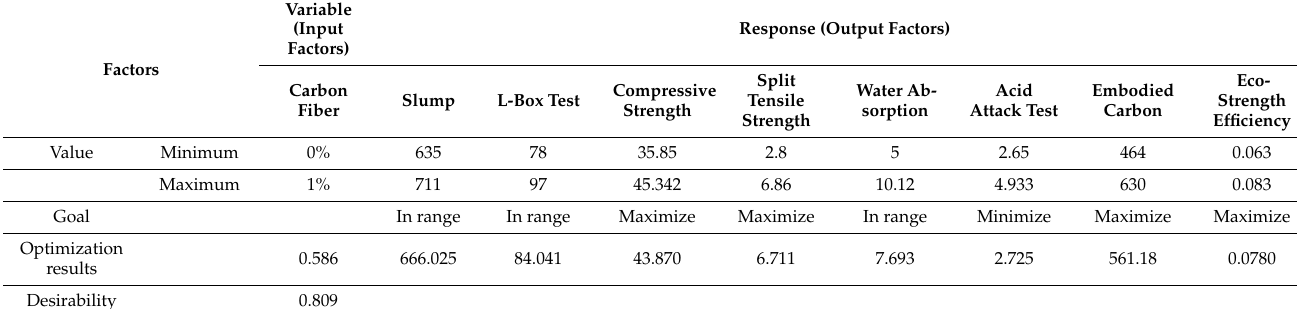
Table 12. Multiobjective Optimization.